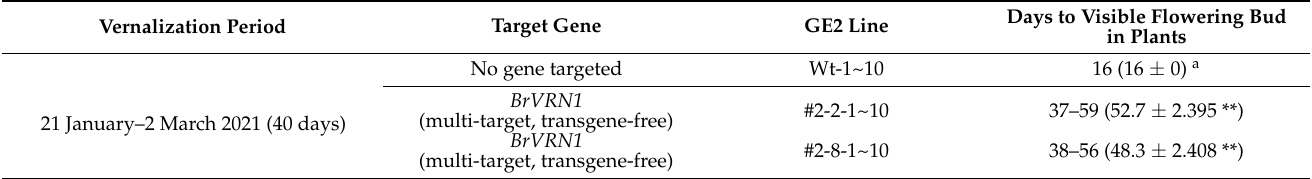
Table 2. Phenotypes of flowering time in Chinese cabbage GE2 mutant plants after vernalization. ‘Transgene-free’ GE2 plants were exposed to low temperature (4 °C) for 40 days.